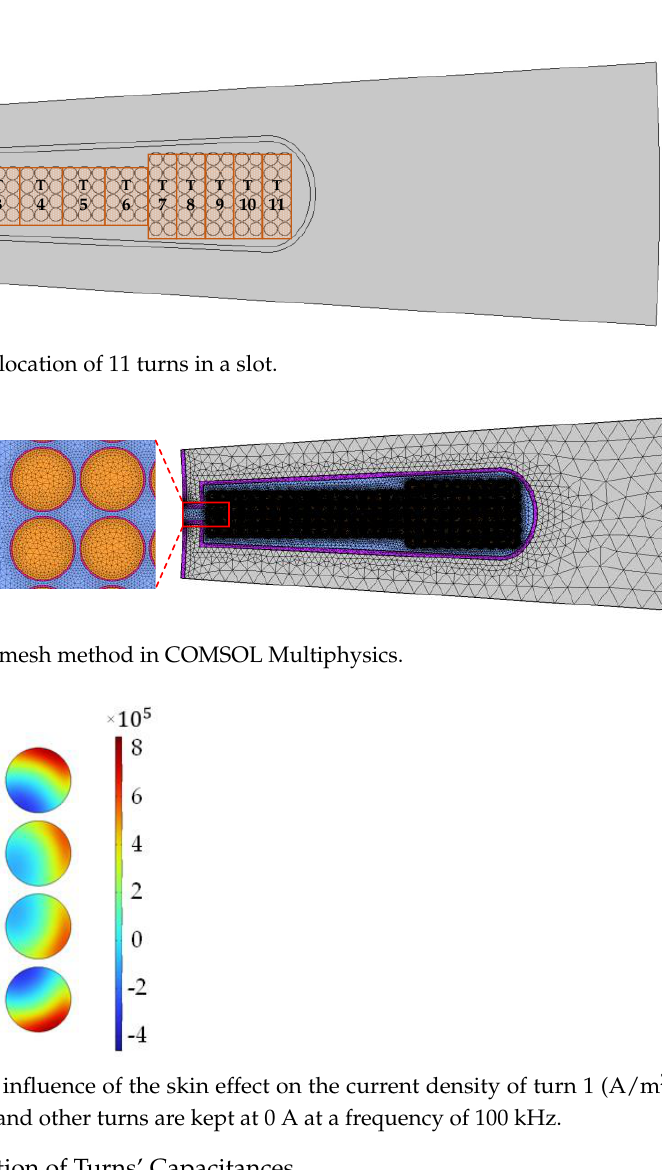
Figure 9. FEM model geometry implemented in COMSOL Multiphysics; ( a ) complete 48-slot stator model; ( b ) one slot model. Figure 10. The location of 11 turns in a slot.